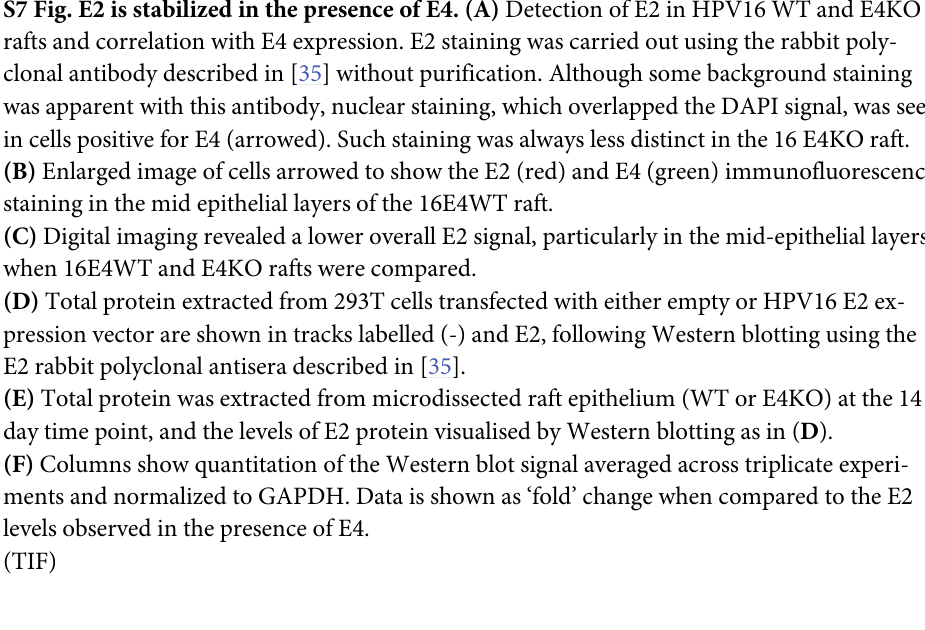
S6 Fig. pIRES-16E1/E2/E4 and pIRES-16E1/E2 gene expression plasmids. (A) Schematic representation of the E1/E2/E4 and the E1/E2 expression vectors (pIRES-16E1/E2/E4 and pIRES-16E1/E2). DNA fragment containing intact E1, E2 and E4 genes, or the E1 and E2 genes along with the E4KO gene, were cloned downstream of the CMV promoter in pIRE- SeGFP. The E4 ORF is contained within the E2 ORF but is translated in different reading internal ribosome entry sites